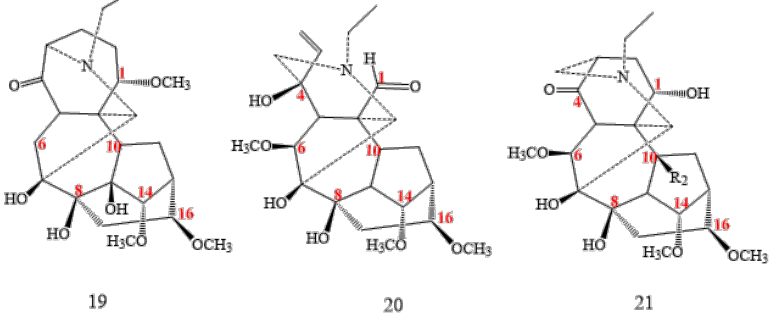
Figure 3. C 18 -rearranged DAs.